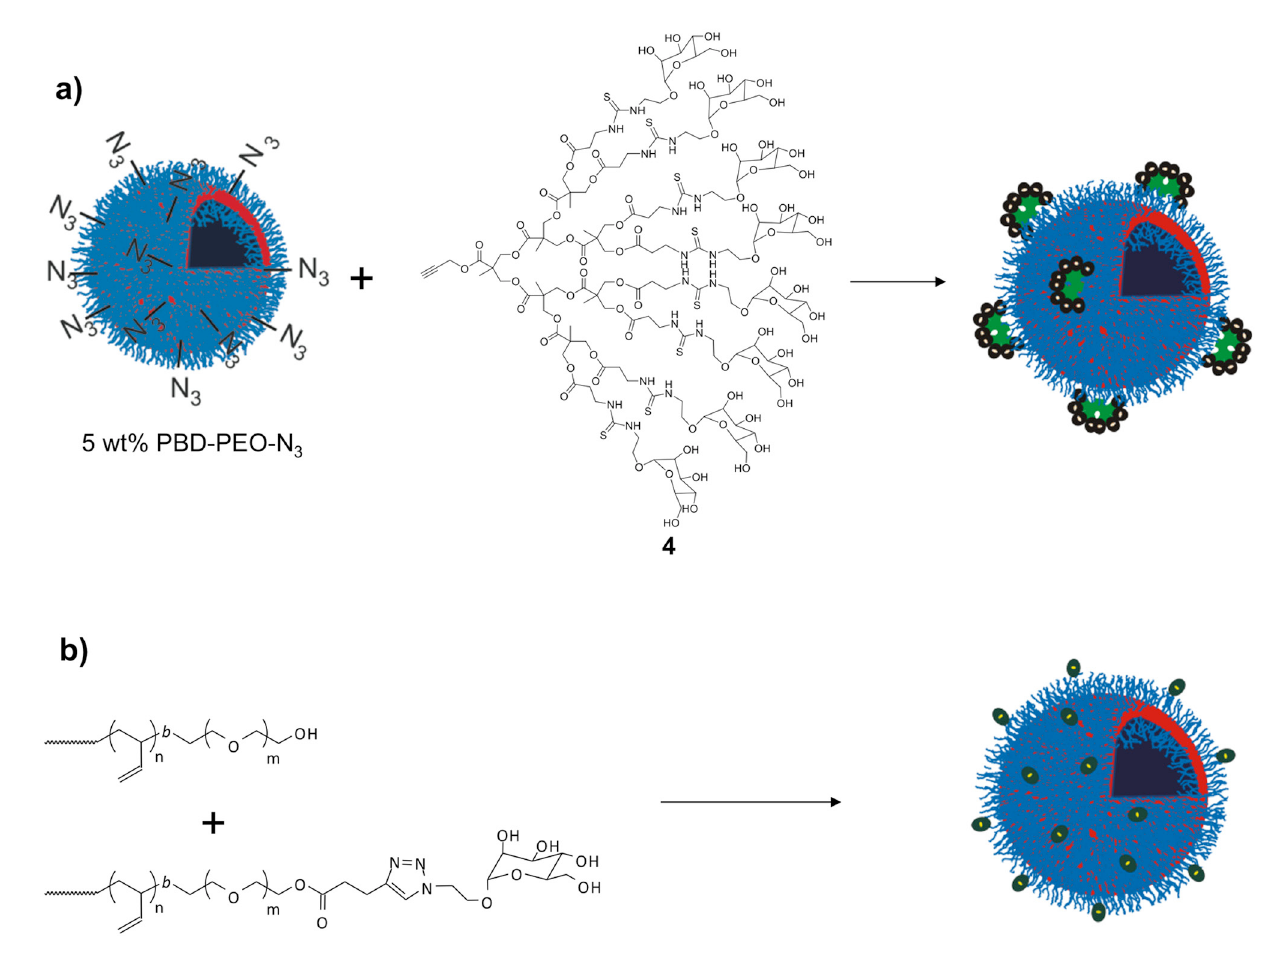
FIGURE 7 - Schematic for the preparation of a) dendritic mannose polymersomes; b) non-dendritic mannose